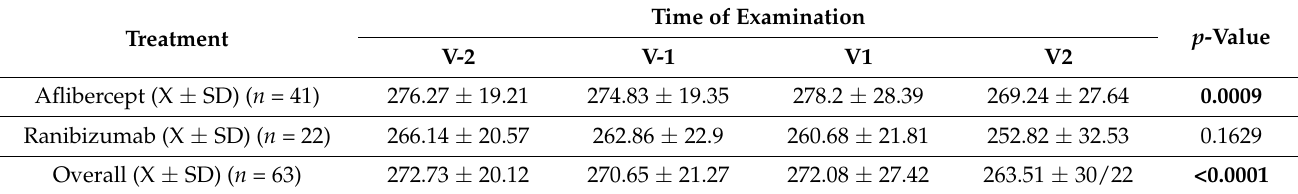
Table 3. Average central retinal thickness [ µ m] during follow-up.